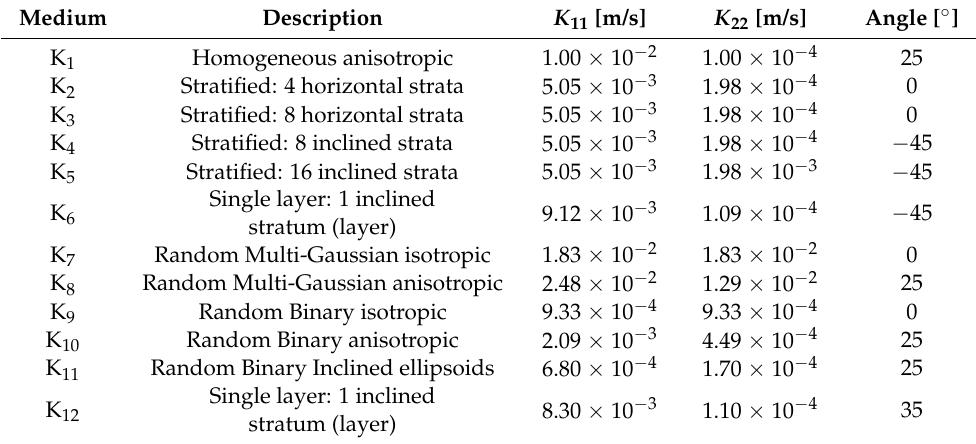
Table 3. Reference conductivity tensors for the twelve two-dimensional synthetic